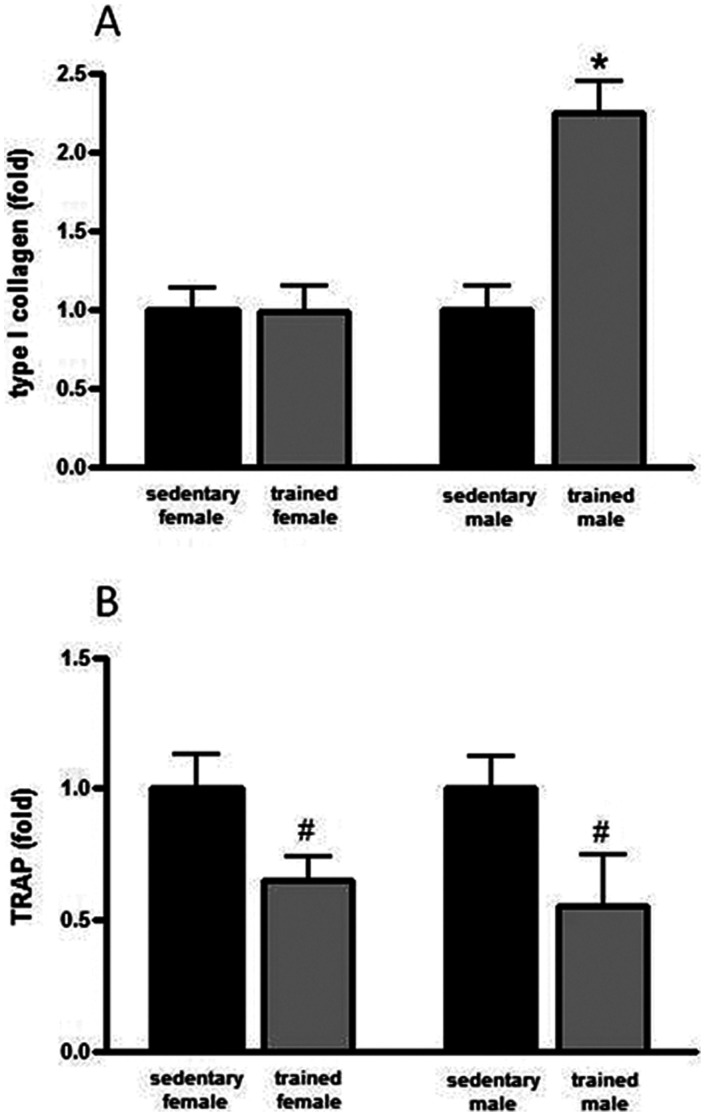
mRNA expression of COL I (panel A) and TRAP (panel B) (data are expressed as the mean and SEM).
*indicates p<0.05 when compared with their sedentary counterparts (within-sex comparisons).